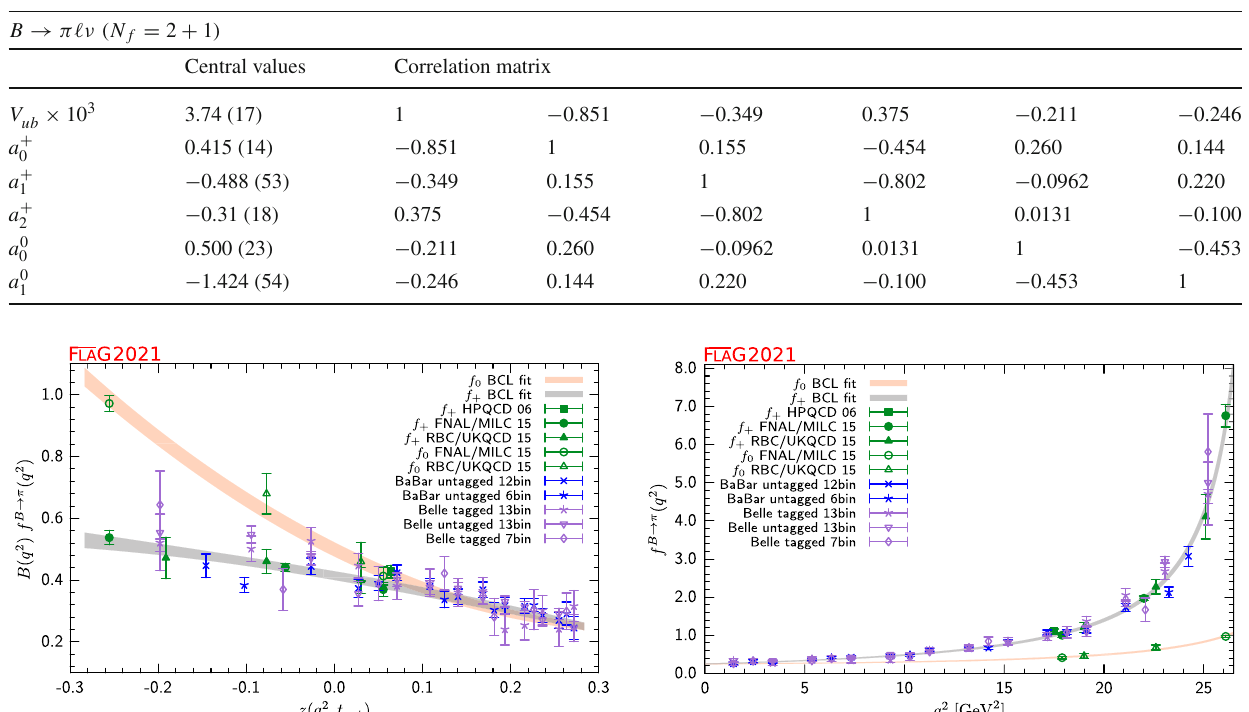
(cid:10) χ 2 / dof = 1 . 19.